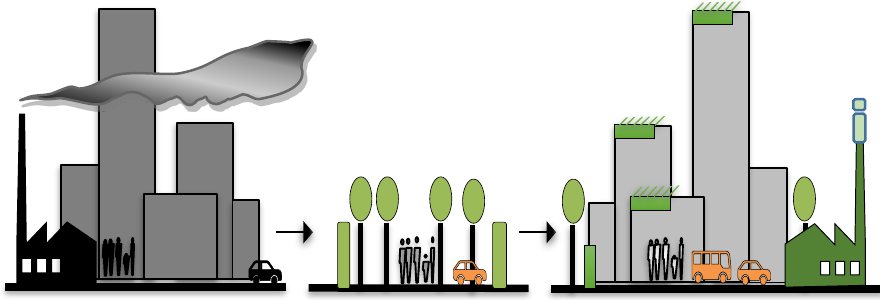
Fig. 5. Prishtina, urban vegetation health protection measures, and healing urban